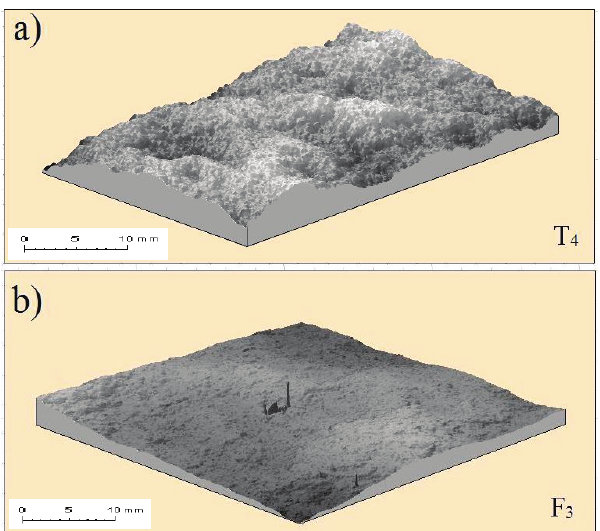
Fig. 7. Visualization of the differences of the roughness between two cleaved